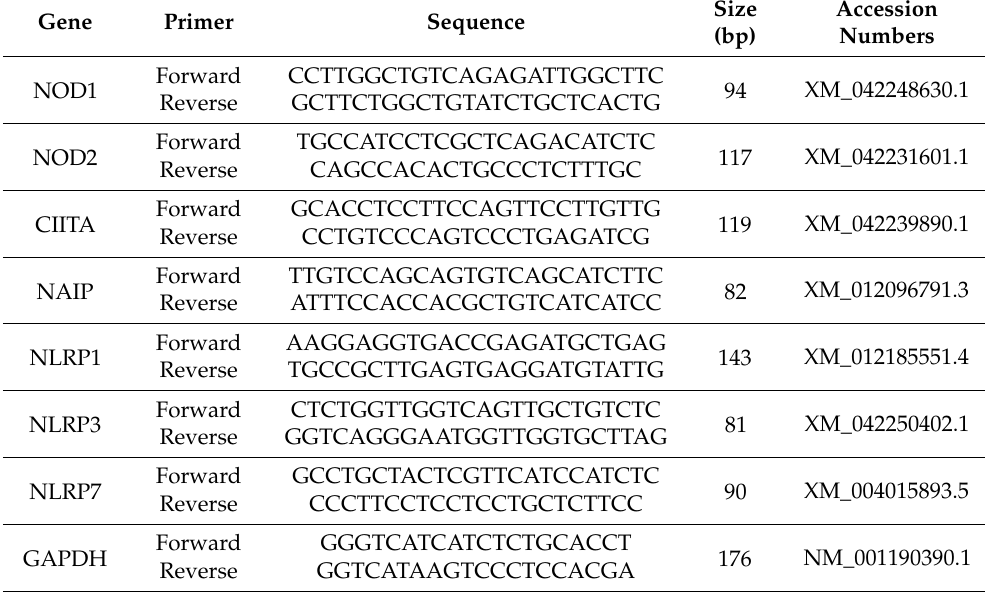
Table 1. The primers